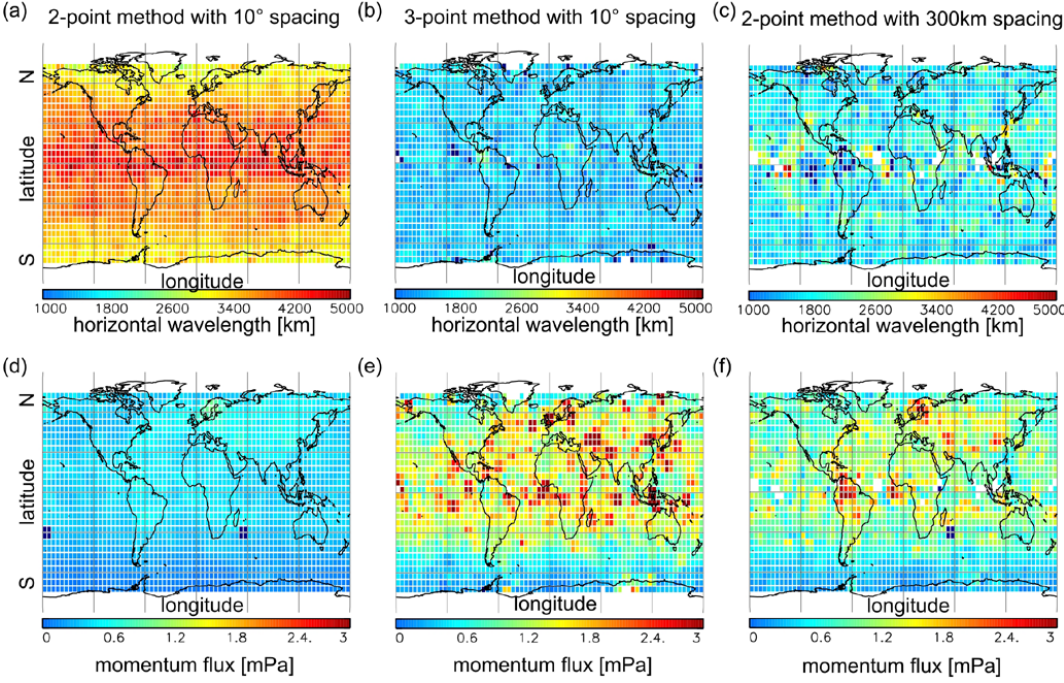
Fig. 7. Horizontal wavelength ( k p ) ( a and c ) and true horizontal wavelength ( b ) with spacings of 10 ◦ ( a and b ) and < 300km ( c ) and the h corresponding momentum flux d − f